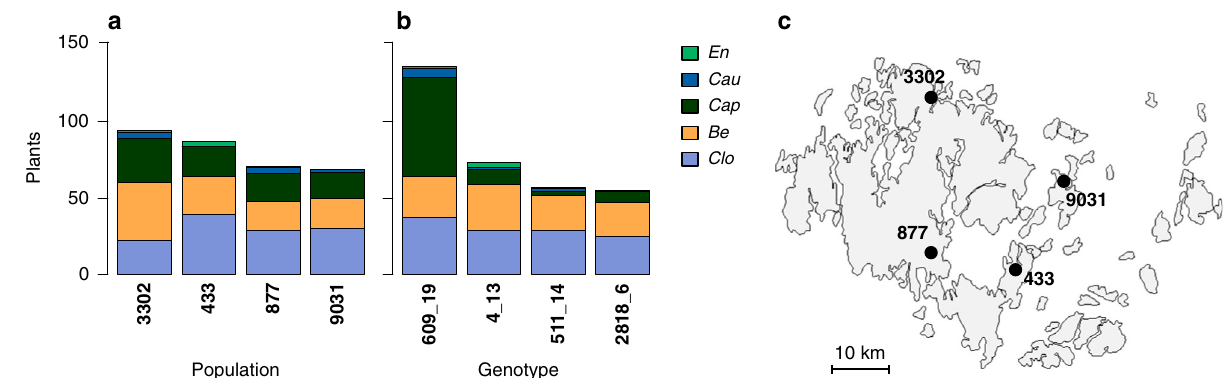
Fig. 1 Virus infections in sentinel plants. Infections are plotted by population ( a ) and genotype ( b ), and the locations of the study populations in the fi eld experiment in the Åland Islands ( c ). The genotypes and populations are ordered from left to right according to decreasing overall number of infections. ‘ Clo ’ refers to Plantago closterovirus , ‘ Be ’ to Plantago betapartitivirus , ‘ Cap ’ to Plantago lanceolate latent virus , ‘ Cau ’ to Plantago latent caulimovirus , and ‘ En ’ refers to Plantago enamovirus .